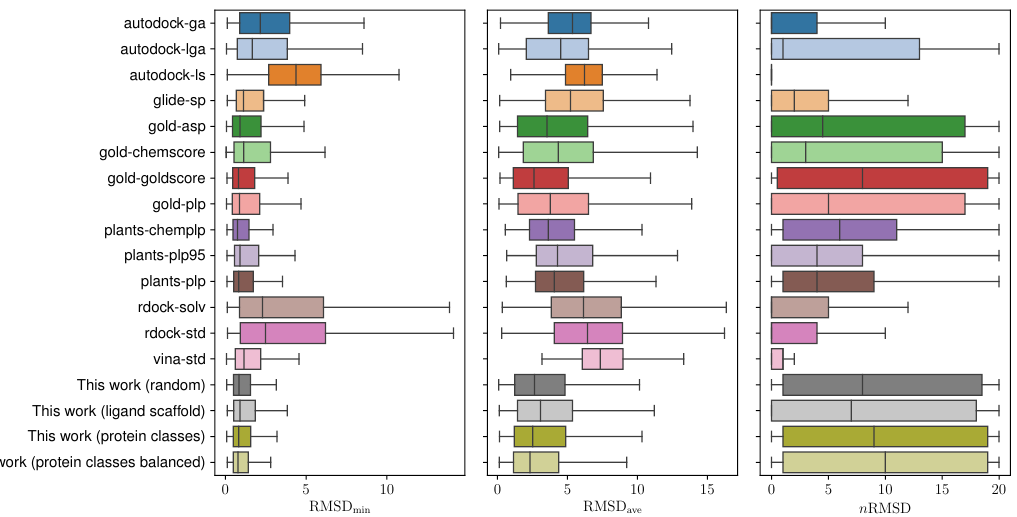
Figure 2. Distribution of RMSD min , RMSD ave , and n RMSD values in a self-docking scenario using the PDBbind v.2017 database of cocrystals, for all the protocols described in Table 3, and the approach proposed in this work under different evaluation scenarios.